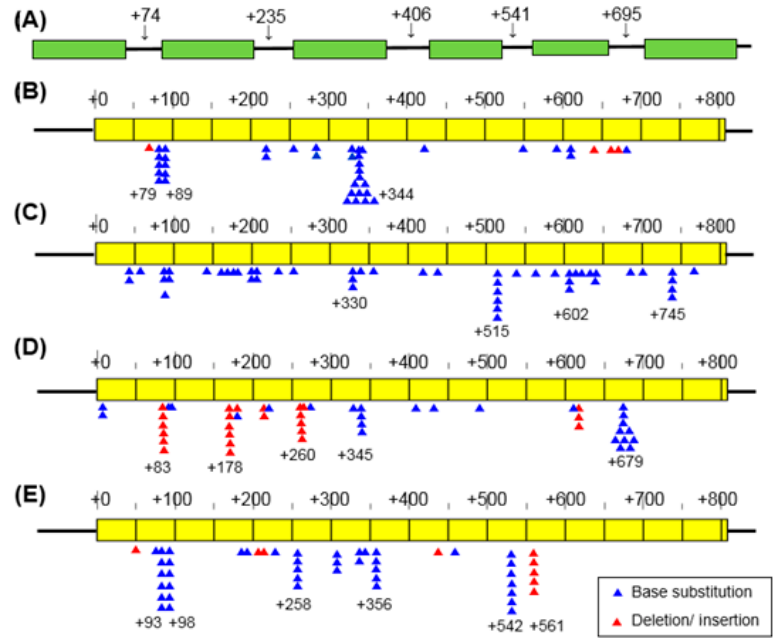
Figure 3. Distribution of mutation sites induced by carbon ion beams (LET 107 keV / µ m) in wild-type and repair-deficient yeast strains. ( A ) Deduced nucleosome structure described in Tanaka et al. [21]. Arrows indicate the approximate position of linker DNA. ( B – E ) Mutation sites observed in rad52 ( B ), ogg1 ( C ), msh2 ( D ), and wild-type ( E ). Blue triangles: substitution mutations. Red triangles: deletion / insertions. Numbers represent the nucleotide positions of the URA3 gene, in which + 1 indicates the position of A in the initiation codon ATG. The gray boxes in ( A ) indicates histone proteins. The white boxes in ( B ) to ( E ) indicate the PCR amplified region. Data of yeast strain S288c (wild-type) was taken from